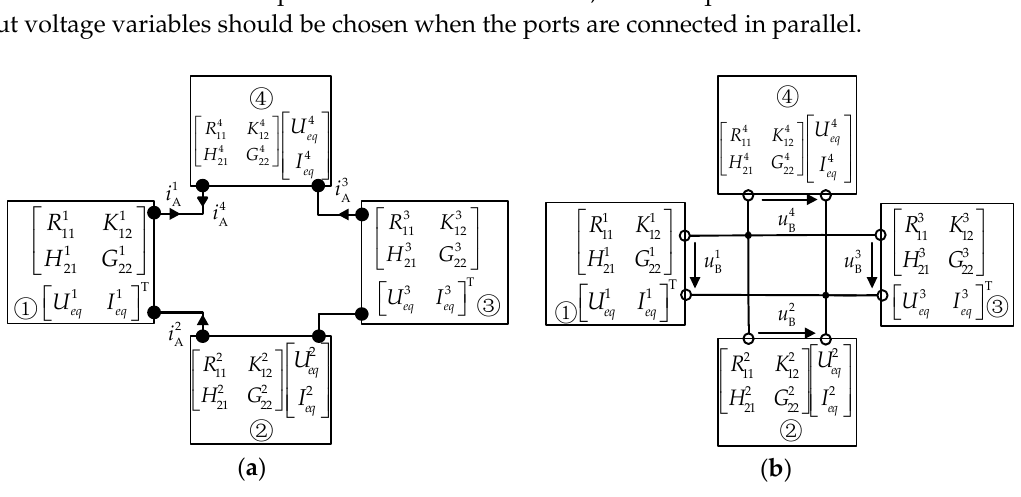
Figure 8. Series and parallel port equivalents connected to solve interface input currents/voltages: ( a ) series port equivalents connected to solve interface input currents; ( b ) parallel port equivalents connected to solve interface input voltages.